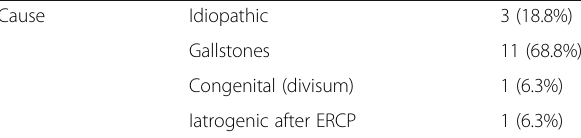
Table 2 Causes of pancreatitis in patient group by percentage Cause